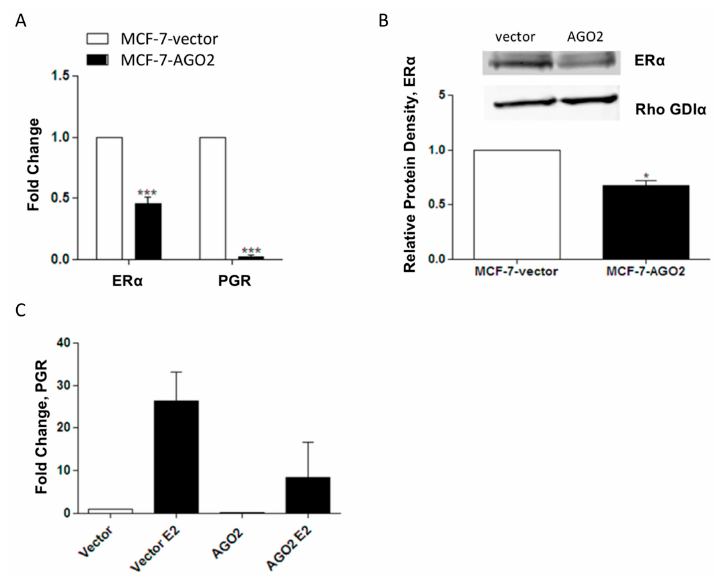
Figure 2. AGO2 expression suppresses ER α function in vitro. ( A ) MCF ‐ 7 ‐ AGO2 cell line was analyzed by quantitative PCR (qPCR) for ER α and progesterone receptor (PGR) expression levels vs. MCF ‐ 7 ‐ vector, n = 3 biological replicates; ( B ) Western blot for ER α protein levels in the MCF ‐ 7 ‐ AGO2 cell line, n = 3 biological replicates; ( C ) qPCR for PGR gene expression levels in MCF ‐ 7 ‐ AGO2 cell line vs. vector following 24 h of stimulation with 1 nM E2, n = 4 biological replicates. Significantly different * p < 0.05, *** p < 0.001. To determine if the changes observed in the MCF ‐ 7 ‐ AGO2 cell line in vitro translated to a similar response in vivo, ovariectomized SCID/Beige female mice were inoculated with either MCF ‐ 7 ‐ vector or MCF ‐ 7 ‐ AGO2 cells in the mammary fat pad in the presence of exogenous E2 (0.72 mg pellet, 60 ‐ day release, vs. placebo). E2 stimulated tumorigenesis was not inhibited by AGO2, and demonstrated significantly greater overall tumor growth kinetics as evaluated with area under the curve analysis (AUC) (Figure 3A,B) [26]. ER α protein expression was next evaluated in AGO2 tumors compared to vector. In our in vivo models there was no significant change in ER α protein expression as observed through immunohistochemistry staining (Figure 3C,D).